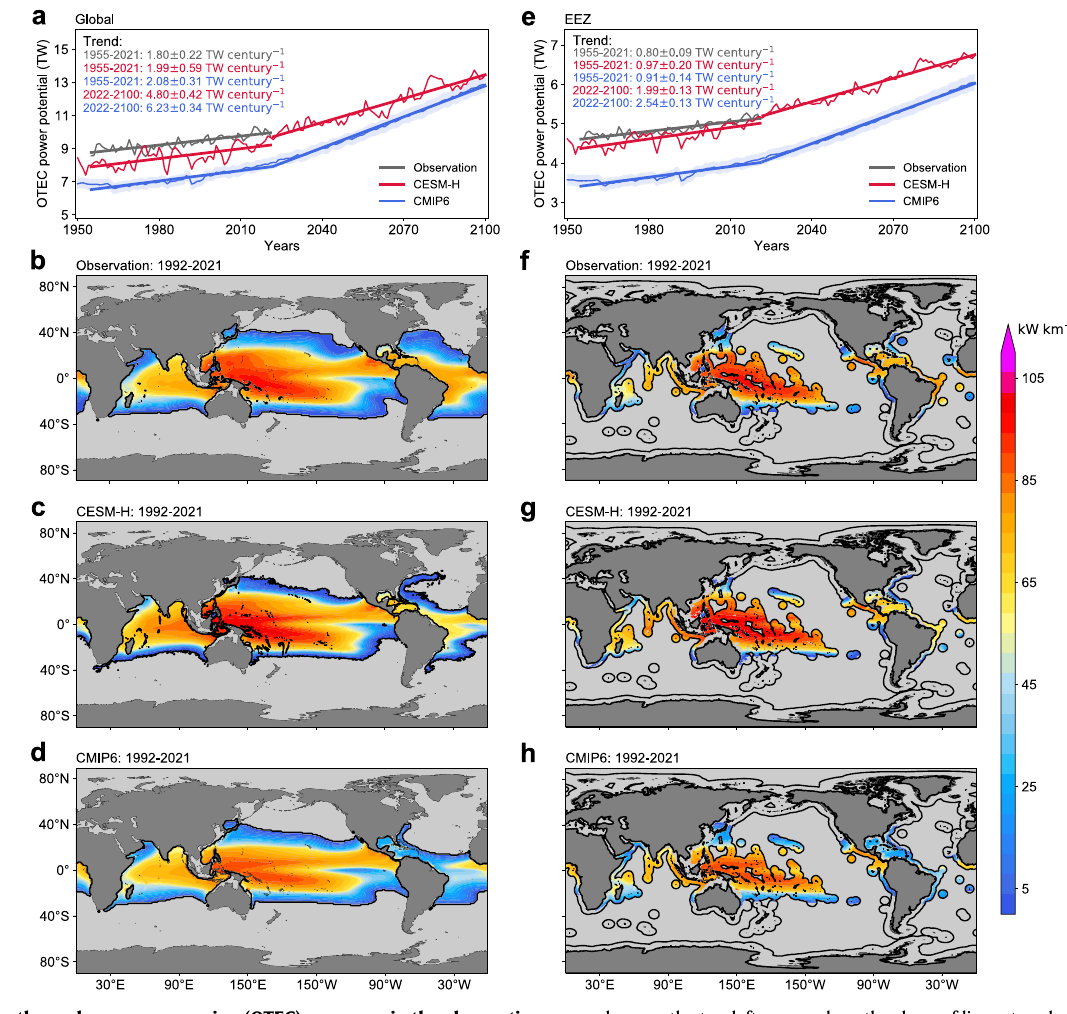
numbers on the top left corner show the slope of linear trends of global OTEC power potential over different periods along with its standard error. b – d Geographic distribution of time-mean (1992 – 2021) OTEC power potential density in the observation, CESM-H and CMIP6 CGCM ensemble mean, respec- tively. e – h Same as a – d but for the OTEC resources within the exclusive economic zone (EEZ). The black solid lines encompass the EEZ across the